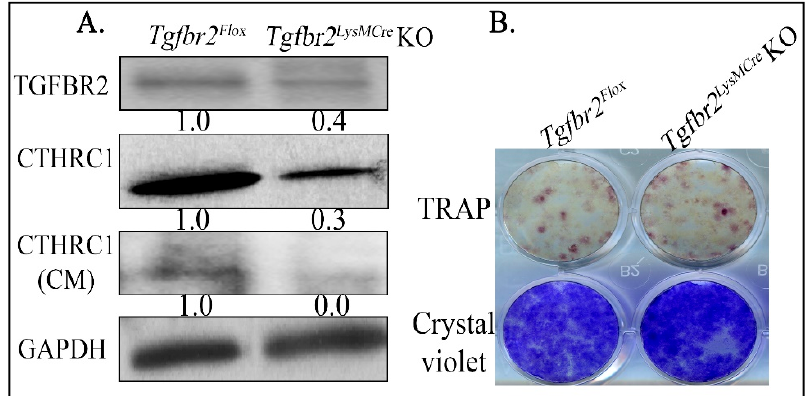
Figure 3. Osteoclasts from Tgfbr2 LysMCre KO mice had lesser expression of CTHRC1 relative to littermate controls. ( A ) Primary osteoclasts were cultured from Tgfbr2 LysMCre KOs and littermate controls. The total cell lysis or conditioned media (CM, after concentration) were subjected to Western blotting. ( B ) Representative images of differentiated osteoclasts from the bone marrow of Tgfbr2 floxE2/floxE2 or Tgfbr2 LysMCre KO mice. Numbers under each blot are relative quantification of the densities normalized to GAPDH. Experiments were repeated at least three times with same results. More than 12 mice per group were used for collecting bone marrow.